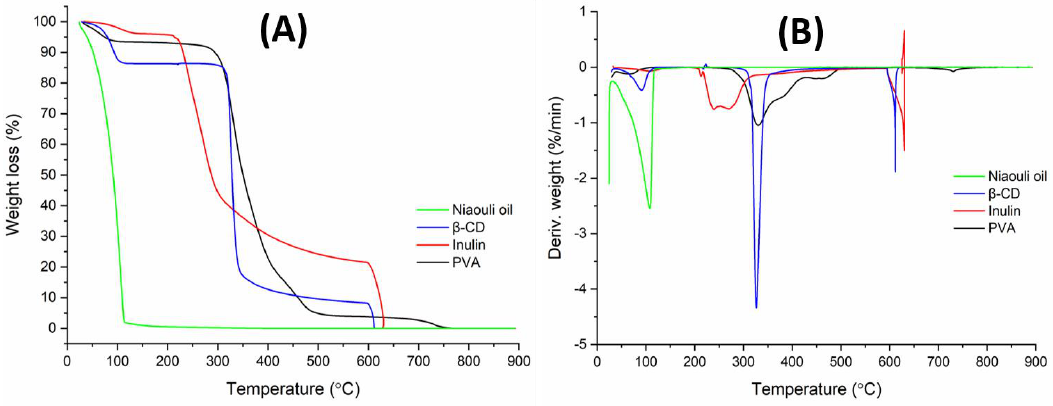
Figure 7. ( A ) TGA curves and ( B ) DTG curves of PVA, inulin, β -CD, and niaouli essential oil.